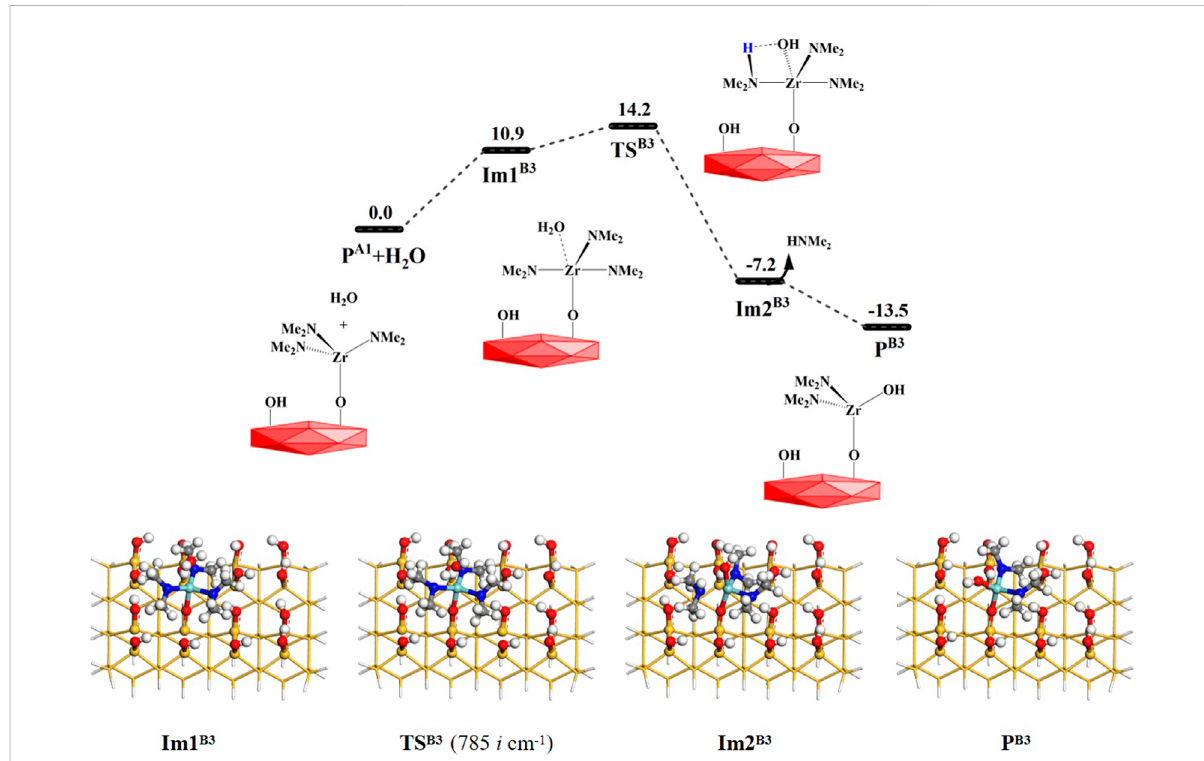
FIGURE 7 Gibbs free energy ( Δ G , kcal/mol) pro fi les of the B3 section of the H 2 O reaction with the aminated surface.